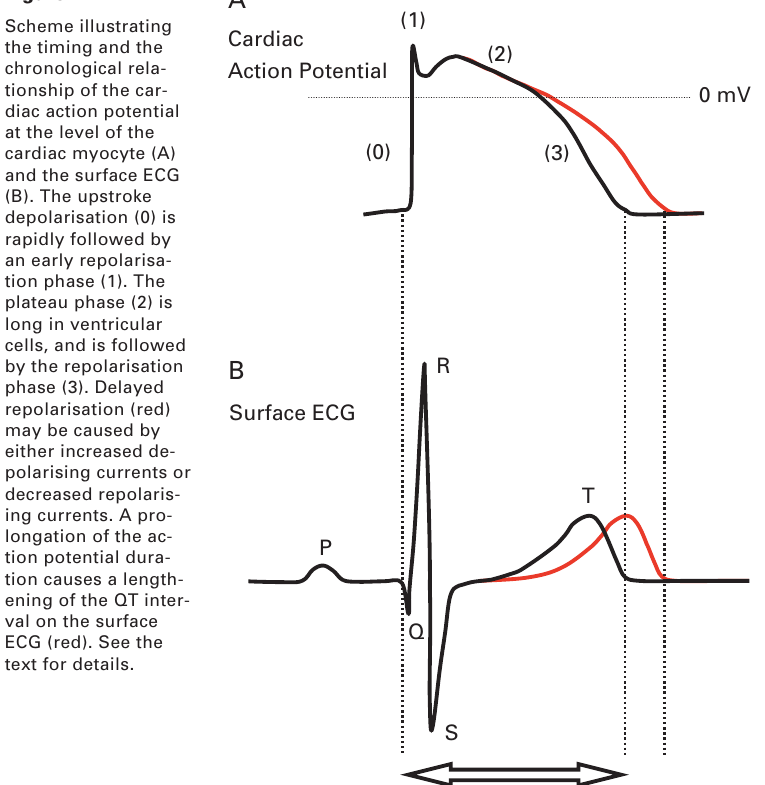
Scheme illustrating the timing and the chronological rela- tionship of the car- diac action potential at the level of the cardiac myocyte (A) and the surface ECG (B). The upstroke depolarisation (0) is rapidly followed by an early repolarisa- tion phase (1). The plateau phase (2) is long in ventricular cells, and is followed by the repolarisation phase (3). Delayed repolarisation (red) may be caused by either increased de- polarising currents or decreased repolaris- ing currents. A pro- longation of the ac- tion potential dura- tion causes a length- ening of the QT inter- val on the surface ECG (red). See the text for